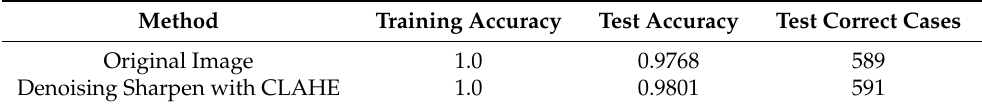
Table 8. Effect of the proposed method on WHU-RS19 dataset.